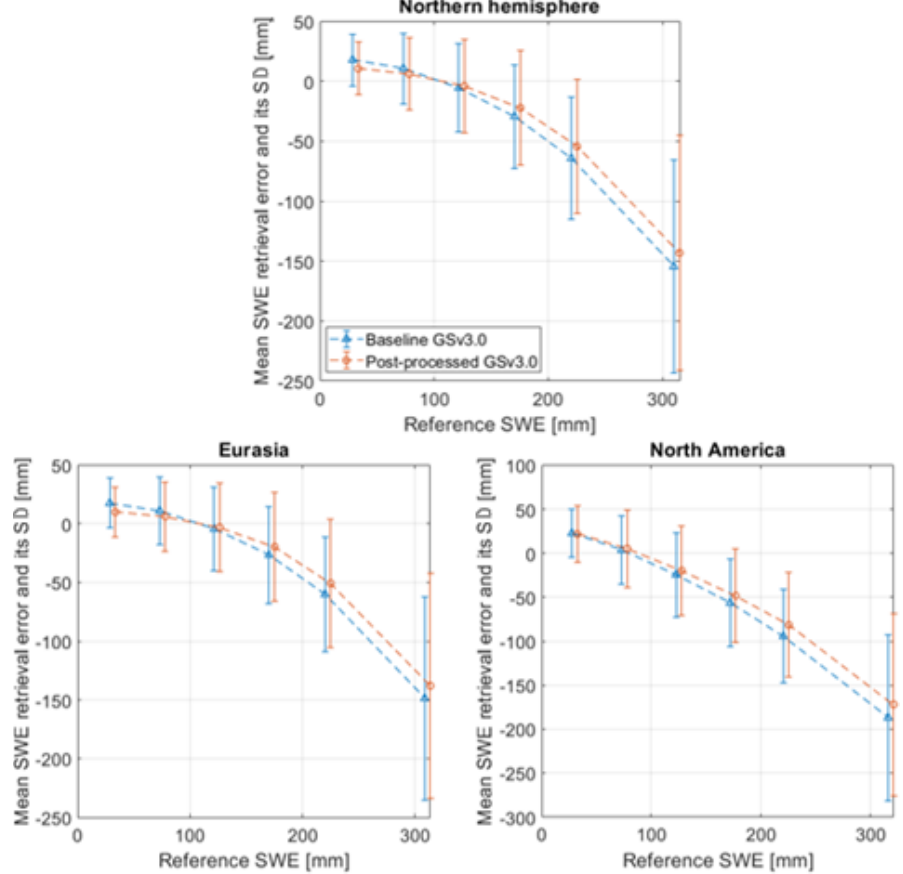
Figure 9. Comparisons of the mean error and standard deviations between baseline and post-processed SWE datasets.